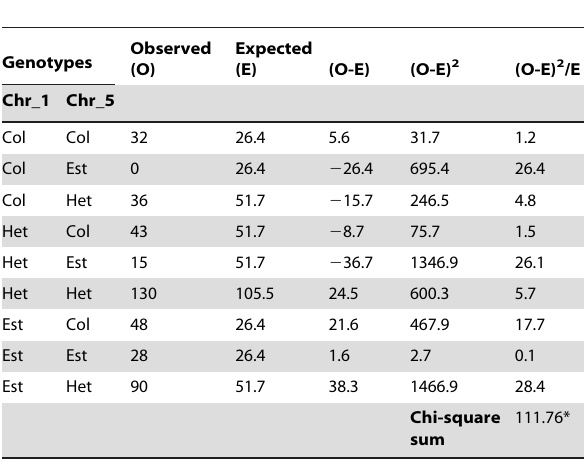
Table 2. Chi-squared analysis of the genotypes in 422 F 2 plants derived from a cross between Est-1 and